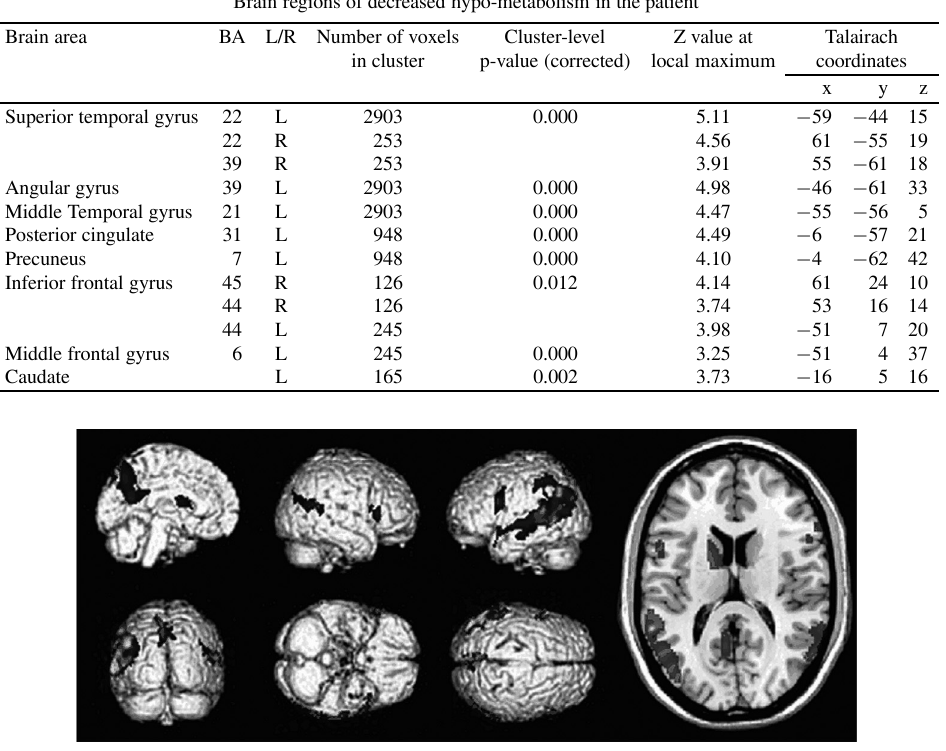
Fig. 1. Areas of hypometabolism revealed by FDG-PET in the patient compared to healthy